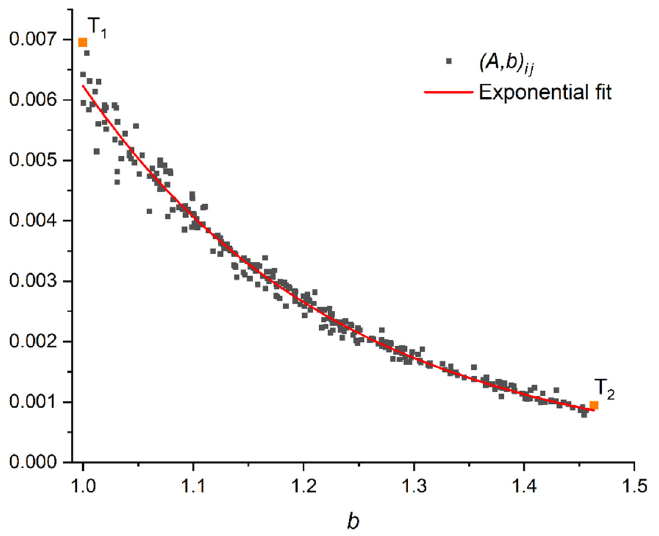
Figure 9. Scatterplot of ( A ∗ , b ∗ ) for the results of calibration of Sensor2 on 18 April 2022 with the adjusted power–law curve. Table 2. Results for the case study.